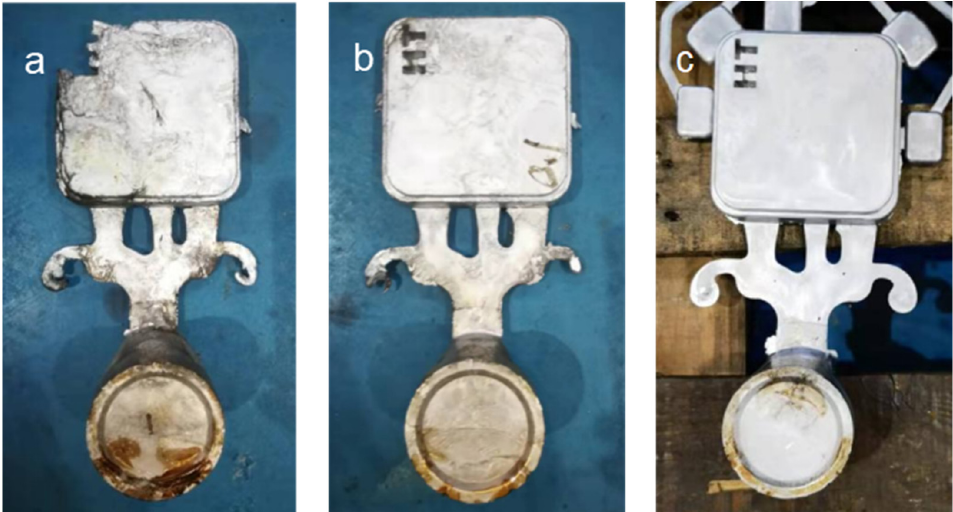
Figure 5. Castings produced during the preheating cycles: ( a ) casting obtained during the first cycle, ( b ) casting obtained during the fourth cycle and ( c ) casting obtained during the tenth cycle.